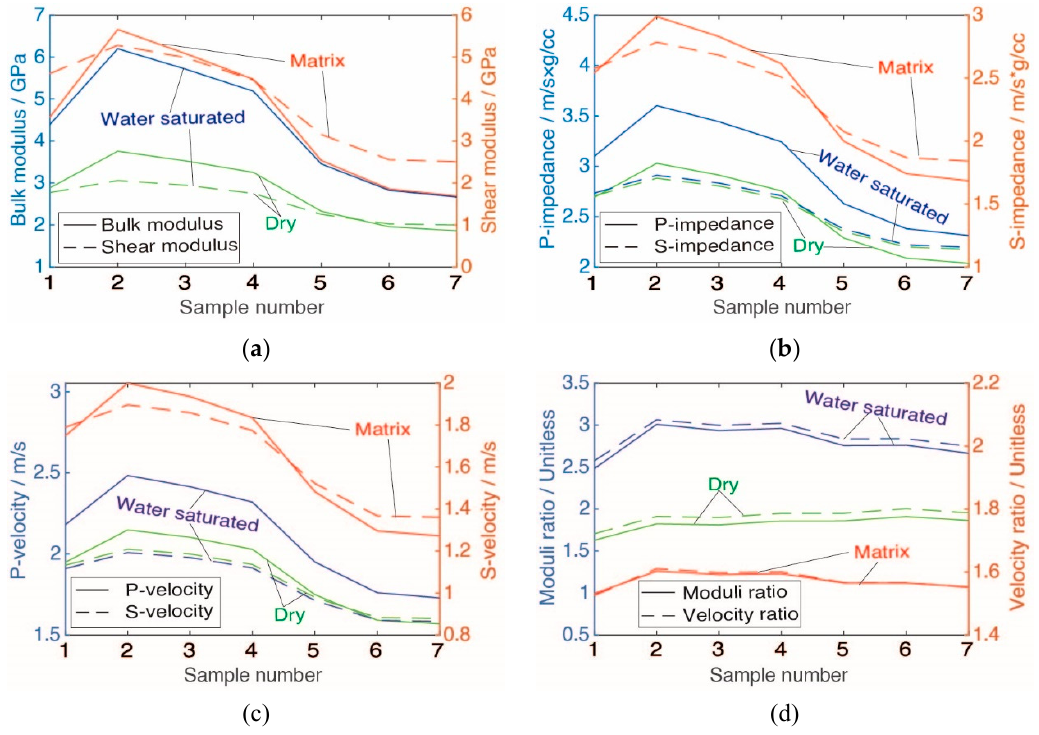
Figure 6. Calculated bulk and shear moduli ( a ), P- and S-impedances ( b ), P- and S-velocities ( c ), and modulus and velocity ratios ( d ) for core matrices, dry cores, and water-saturated cores.